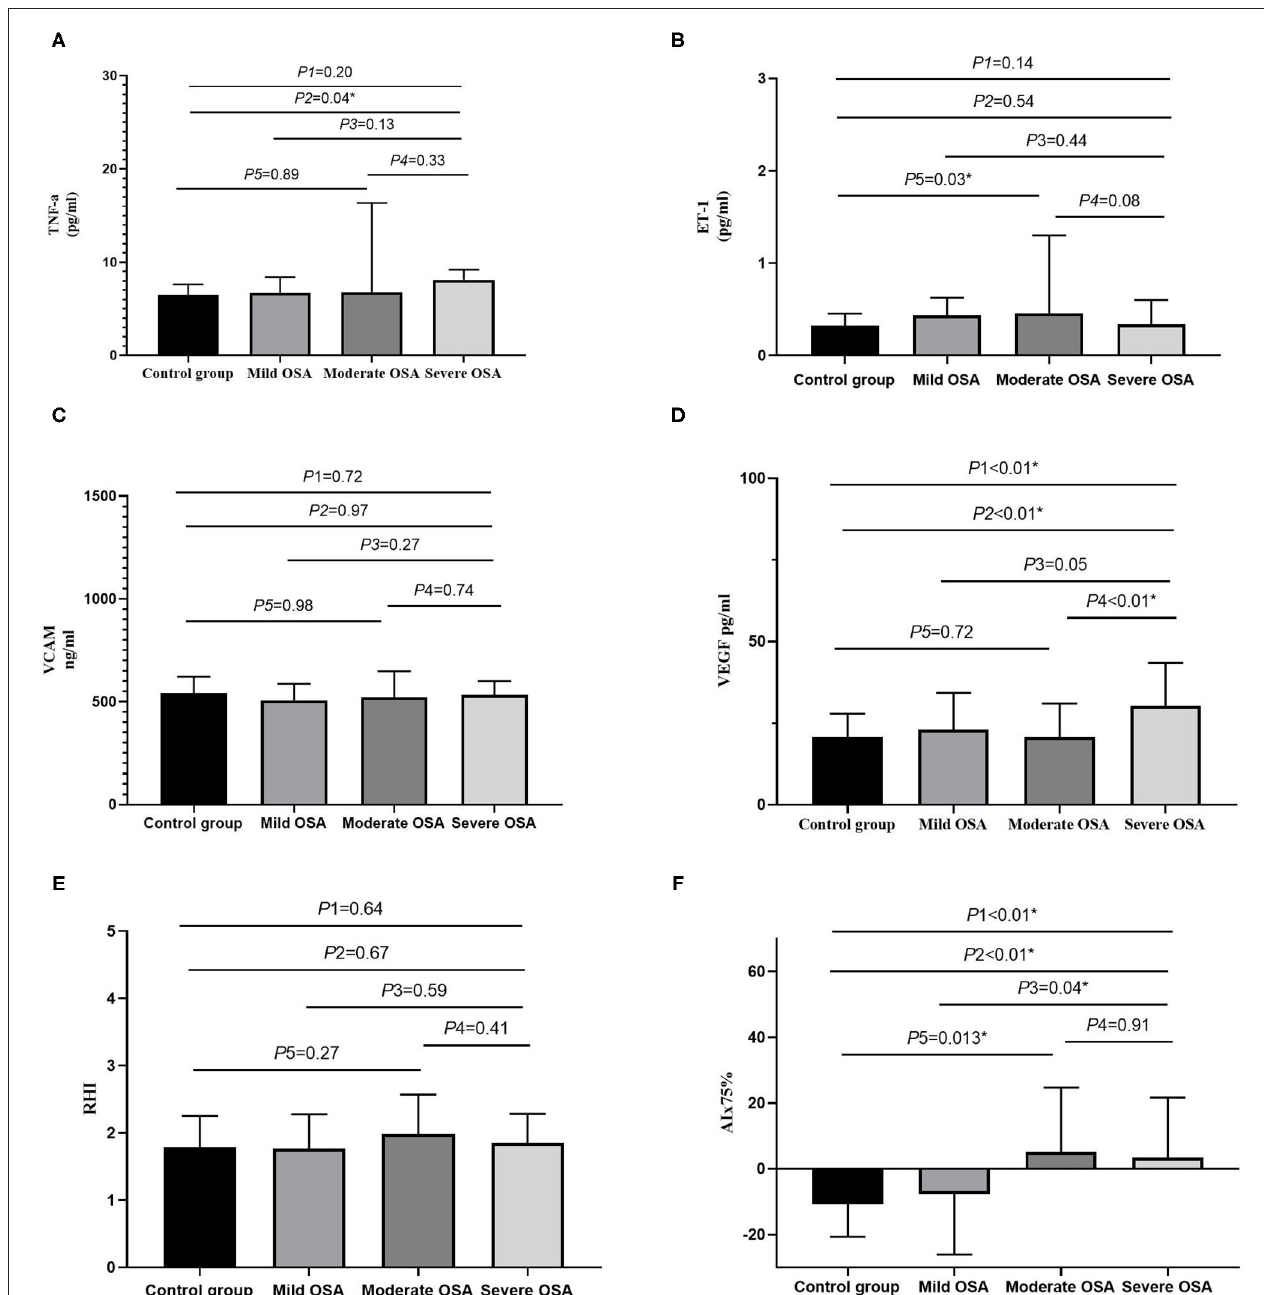
FIGURE 2 | The bar diagrams showing markers in patients with OSA. (A) The relationship between TNF- α and OSA severity. (B) The relationship between ET-1 and OSA severity. (C) The relationship between VCAM and OSA severity. (D) The relationship between VEGF and OSA severity. (E) The relationship between RHI and OSA severity. (F) The relationship between AIx75 and OSA severity. AI, arousal index; AHI, apnea hypopnea index; AIx75, augmentation Index@75 beats/minute; BMI, body mass index; ET-1, endothelin-1; GLU, glucose; HbA1C, hemoglobin A1C; LSpO 2 , lowest pulse arterial oxygen saturation; RHI, reactive hyperaemia index; SpO 2 , oxygen saturation; T90, percentage of sleep time with oxygen saturation < 90%; TNF- α , tumor necrosis factor alpha; VCAM, vascular cell adhesion molecule; VEGF, vascular endothelial growth factor; P 1, four groups comparison; P 2, severe OSA vs. control group; P 3, severe OSA vs. mild OSA; P 4, severe OSA vs. moderate OSA; P 5, moderate OSA vs. control group; * P <